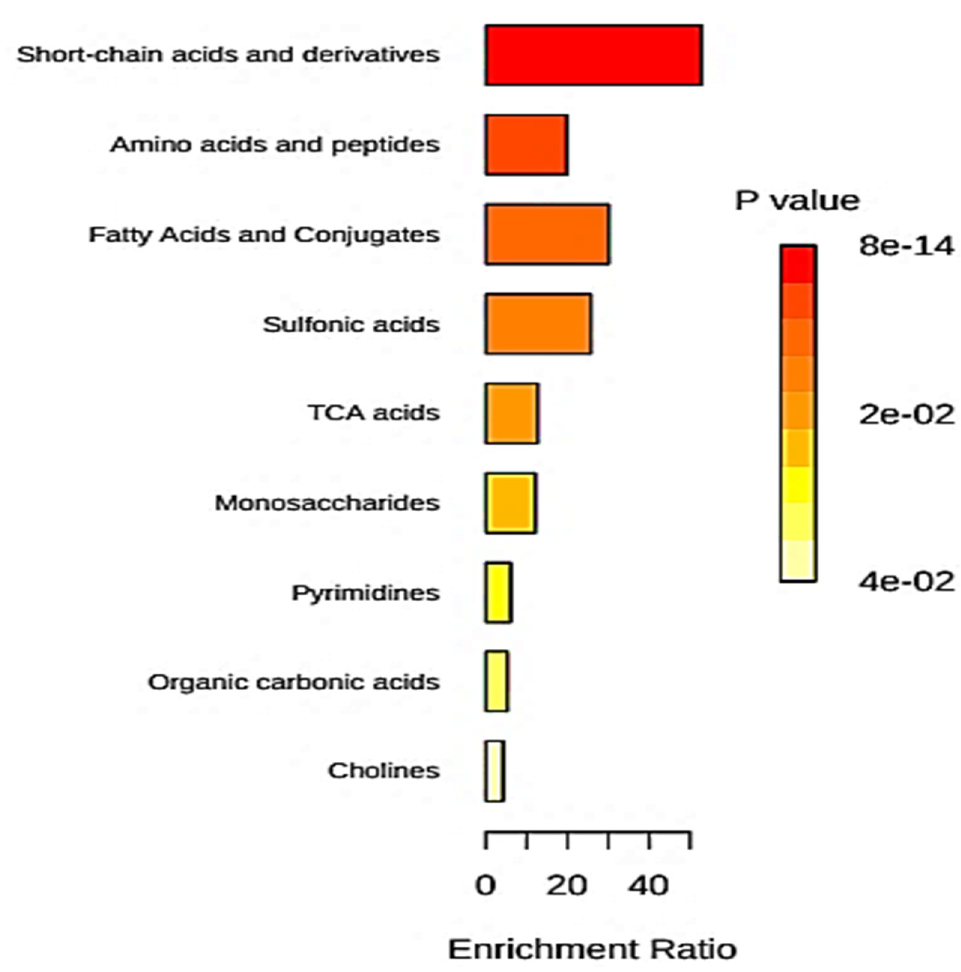
Figure 9. Main Family Metabolites—Enrichment Overview. Enrichment overview of FDR- corrected p values for main family metabolites: short-chain acids and derivatives, 7.08 × 10 − 13 ; amino acids and peptides, 2.78 × 10 − 10 ; FAs and conjugates, 6.78 × 10 − 9 ; sulphonic acids, 6.33 × 10 − 7 ; tricarboxylic acid cycle (TCA) acids, 5.99 × 10 − 4 ; monosaccharides, 6.79 × 10 − 4 ; pyrimidines, 1.75 × 10 − 2 ; organic carboxylic acids, 2.40 × 10 − 2 ; and cholines, 3.99 × 10 − 2 . This analysis used the KEGG 80-entry pathway-analysis metabolite sets for homo sapiens , and the computation of Q statistics was that described above in Figure 8.